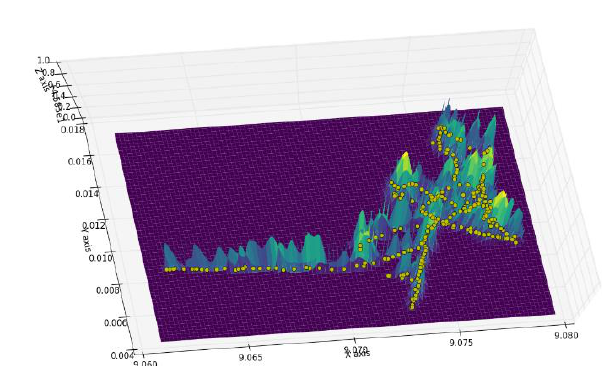
Figure 15 . Gaussian 3D visualization of neurons using MEP-Clustering algorithm.